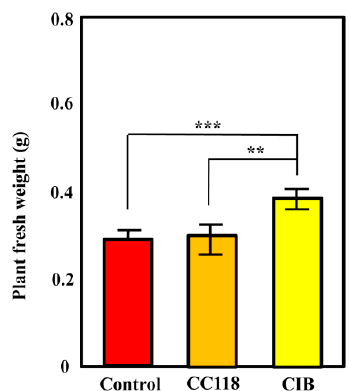
Figure 1. Ability of Azoarcus sp. CIB to promote the growth of rice. Rice seedlings inoculated with E. coli CC118 (pSEVA237) (CC118) (orange column), Azoarcus sp. CIB (pSEVA237) (CIB) yellow column), or non-inoculated seedlings (Control) (red column), were grown for 4 weeks in a growth chamber under controlled conditions. Total fresh weight of each plant in grams (g) was determined. Mean values (20 plants per each condition) are presented with the corresponding errors. The asterisks indicate the statistical significance observed when two conditions are compared applying the One-way ANOVA method and the Bonferroni post hoc test. p < 0.001 (***); p < 0.01